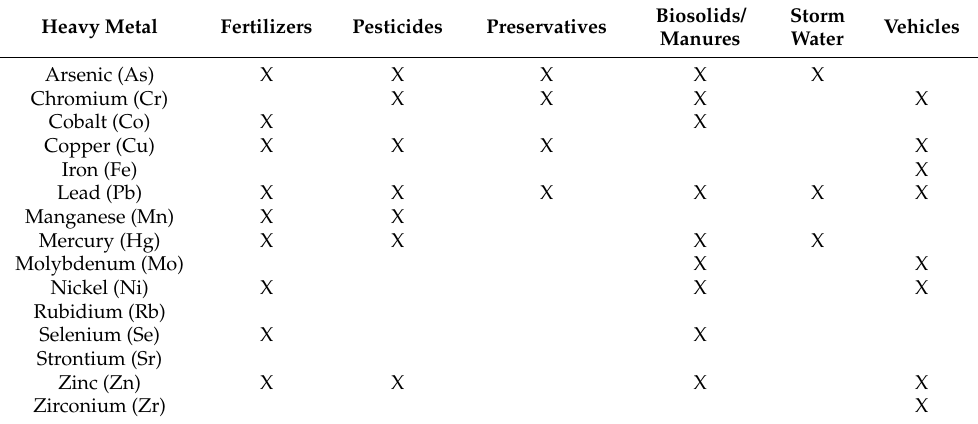
Table A2. Cross-tabulation of selected trace metals and their potential yard landscape